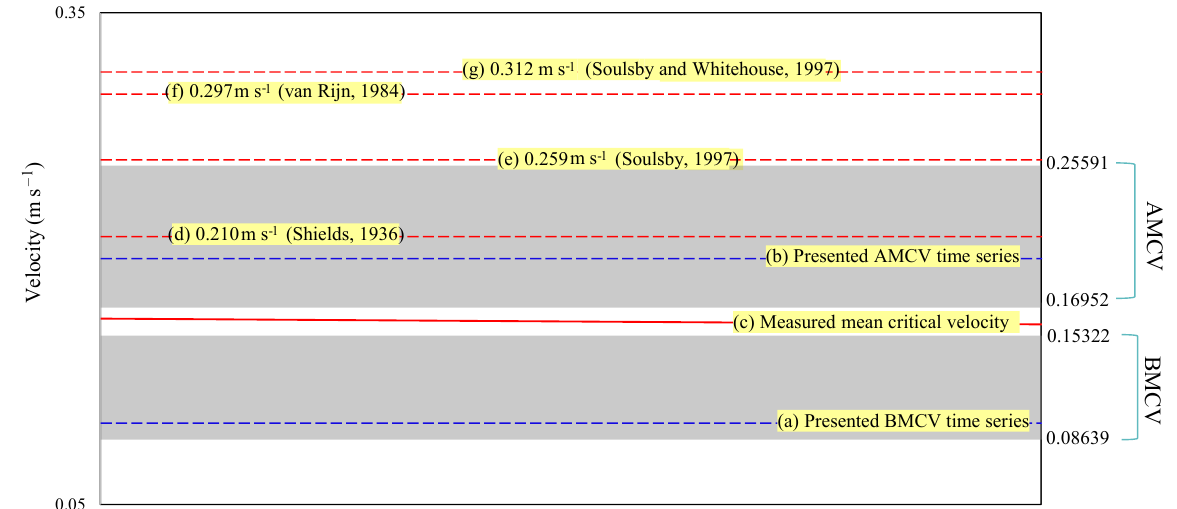
fer. Up-acceleration and down-deceleration events led to marginal effect on transport of momentum and sediment flux